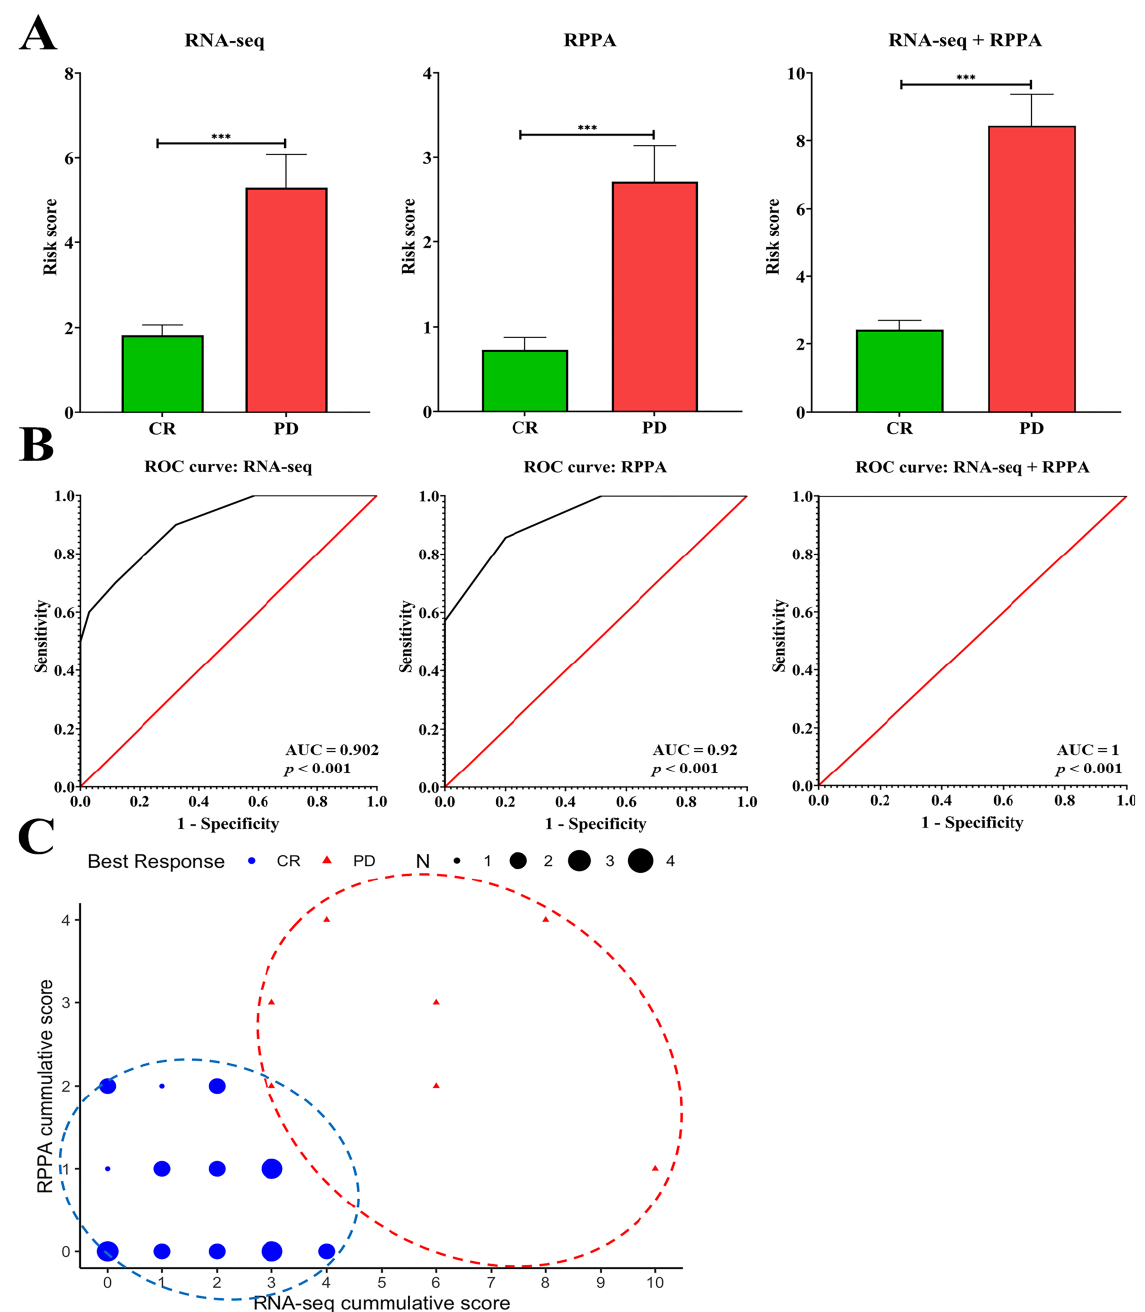
Figure 3. The diagnostic value of the candidate gene set between CR and PD groups. ( A , B ) The risk score from RNA-seq, RPPA, and RNA-seq + RPPA analyses showed excellent and outstanding discrimination ability in identifying PD and CR groups. A p value less than * p < 0.05, ** p < 0.01, and *** p < 0.001 was considered statistically significant. Red line represents the ROC curve for a line of identity. ( C ) The scatter plot provides a quick view of the co-expression of both RNA-seq and RPPA cumulative risk scores of study cohorts with different clinical outcomes. Blue circles represent the group of CR and red circles represents the group of PD.